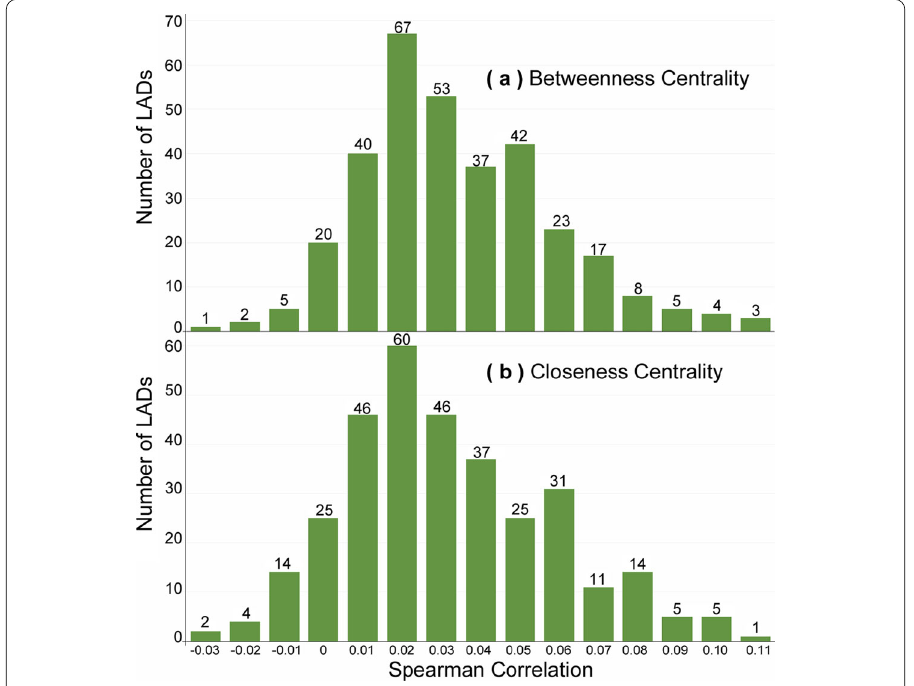
Figure 14 Distribution of Spearman between the density of fast-food outlets and ( a ) betweenness centrality or ( b ) closeness